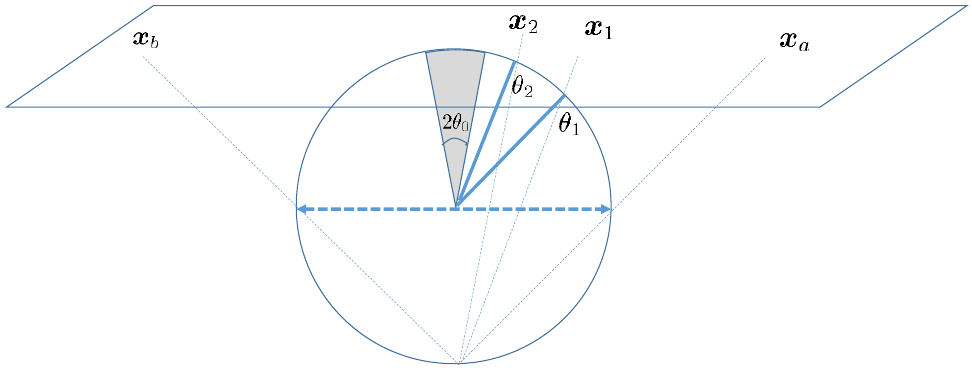
Figure 8 . The stereographic projection in the COM frame of the di-jets and for an exclusion region making a small angle (cid:18) 0 around the positive z axis. The successive, soft, gluon emissions make smaller and smaller angles w.r.t. the positive z axis, (cid:18) 0 (cid:28) (cid:18) 2 (cid:28) (cid:18) 1 . They are projected onto points with decreasing transverse coordinates in the tangent plane: j x 2 j (cid:28) j x 1 j (cid:28) j x a (cid:0) x b j . The evolution is collinear on both sides of the